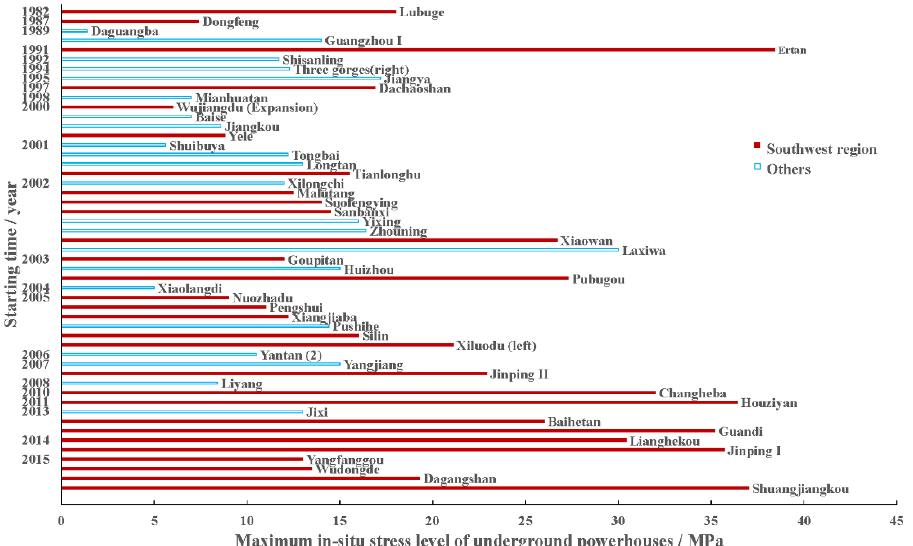
Figure 6. Development history of underground powerhouse in China.